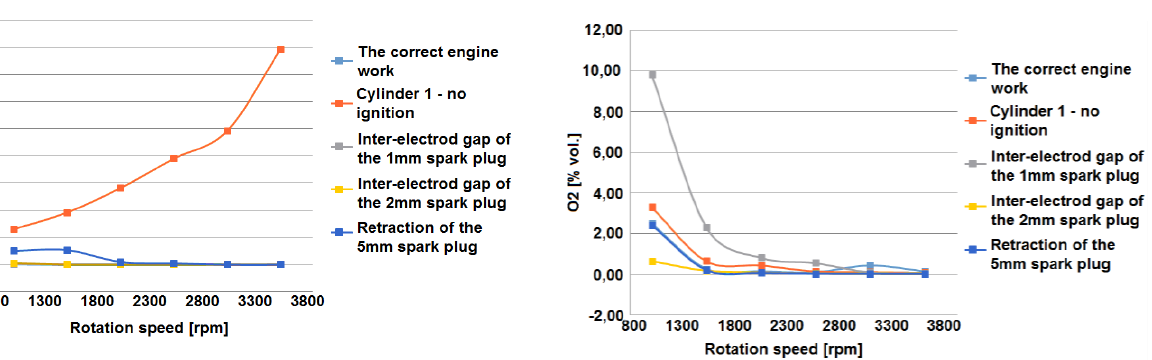
Fig. 16. The content of nitrogen oxides in the exhaust gas of the Fiat 1.1 Fig. 20. The oxygen content in the exhaust gas of the Fiat 1.1 engine engine